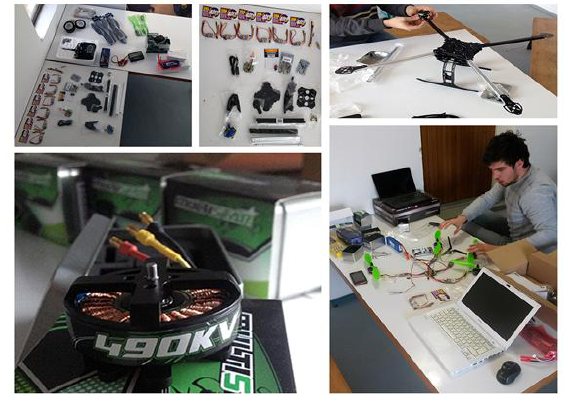
Figure 3: Building the quadrocopter by a group of student from the purchased components